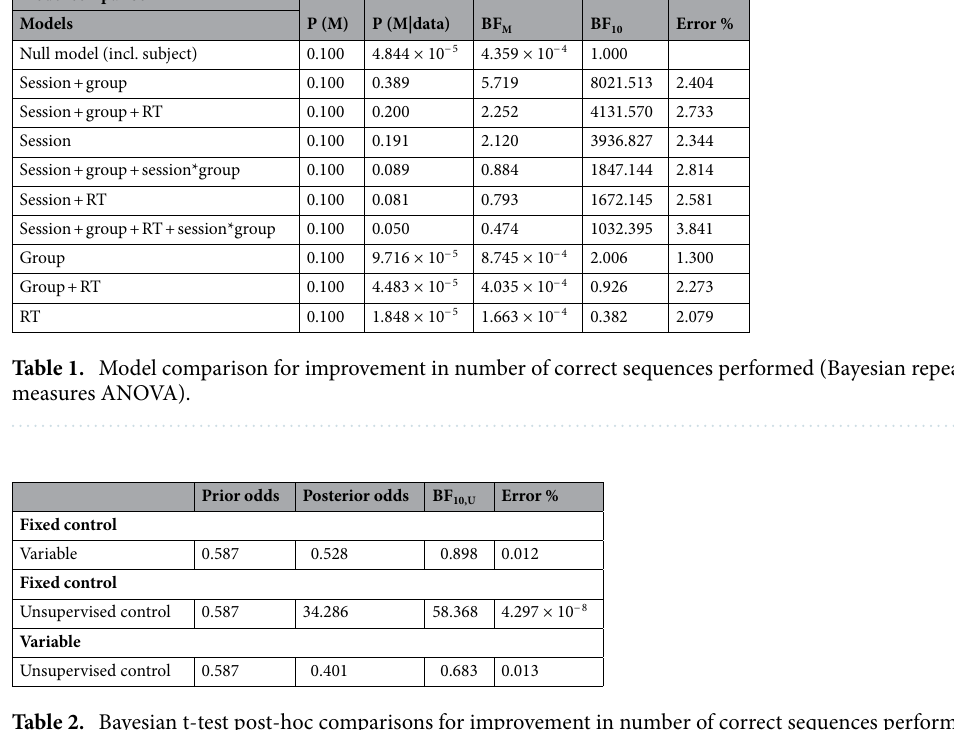
Table 2. Bayesian t-test post-hoc comparisons for improvement in number of correct sequences performed (by